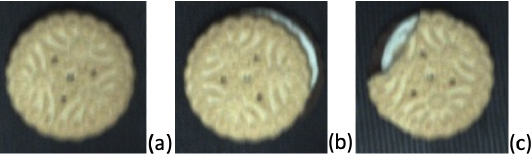
Figure 10. Examples from the BYU Cookie Dataset. The images in this dataset are 100 × 100 pixels from three classes, ( a ) good, ( b ) offset, or ( c )